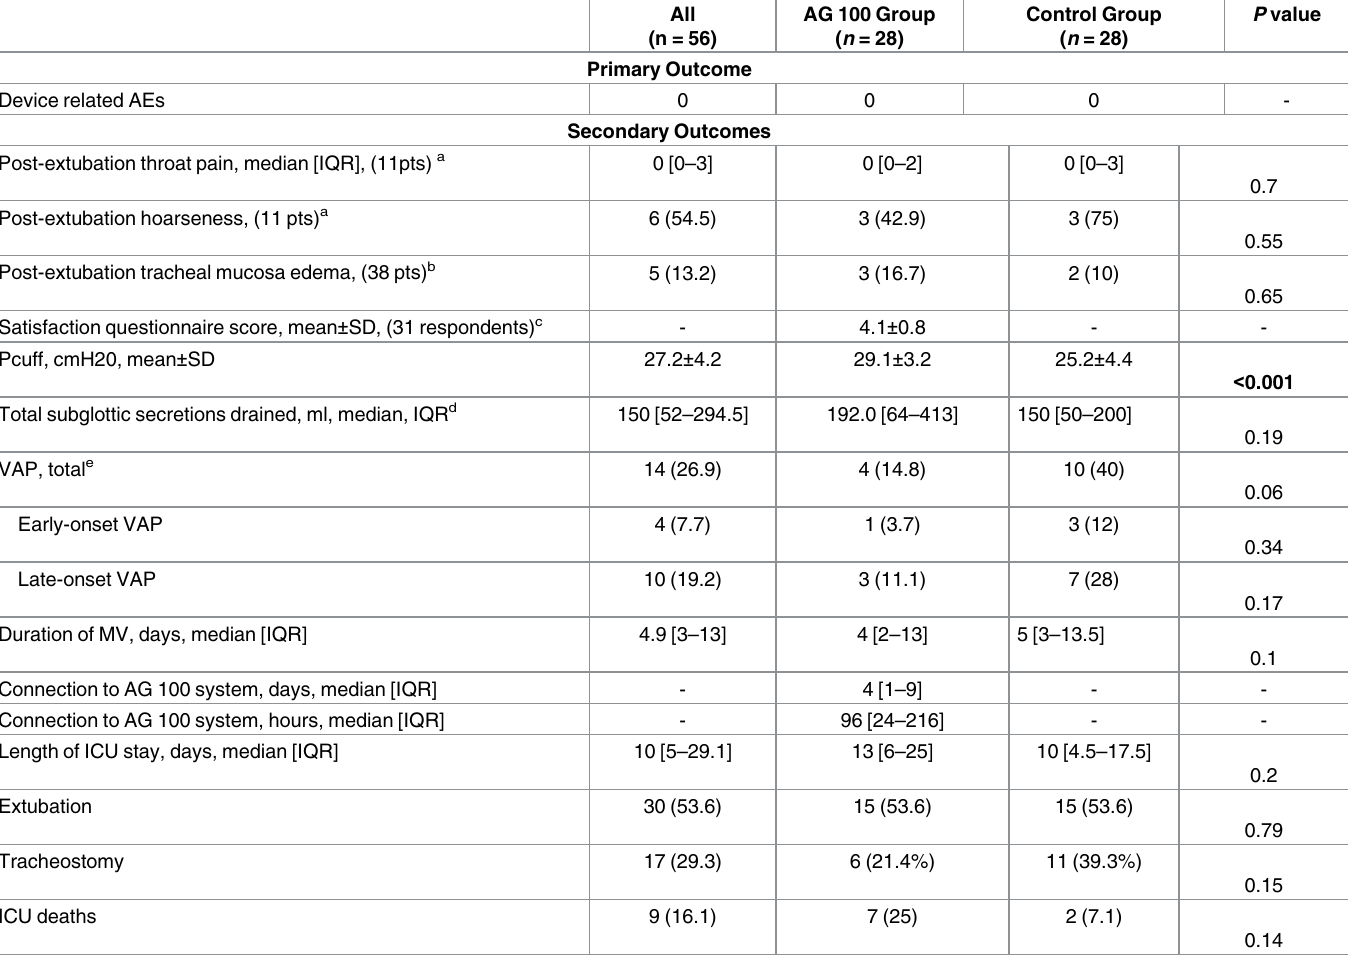
Table 2. Outcome measuresin the Anapnoguard 100 and control